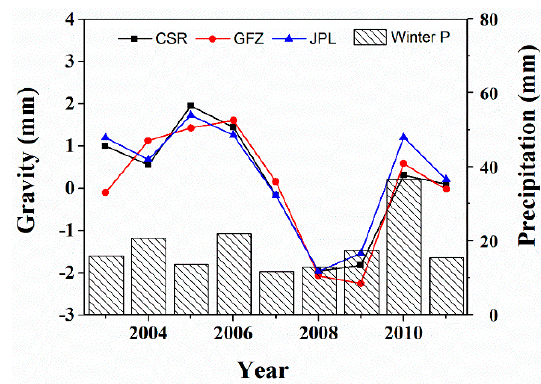
Figure 5. Mean annual GRACE (Gravity Recovery and Climate Experiment) water equivalent thickness in Xinjiang from 2003 to 2011. The histogram represents winter precipitation in mm. GRACE data from all three solutions were plotted: The Center for Space Research (CSR) at the University of Texas at Austin solution, the German Research Center for Geosciences (GFZ) at Helmholz Centre Potsdam solution, and the Jet Propulsion Laboratory (JPL) at the California Institute of Technology solution.